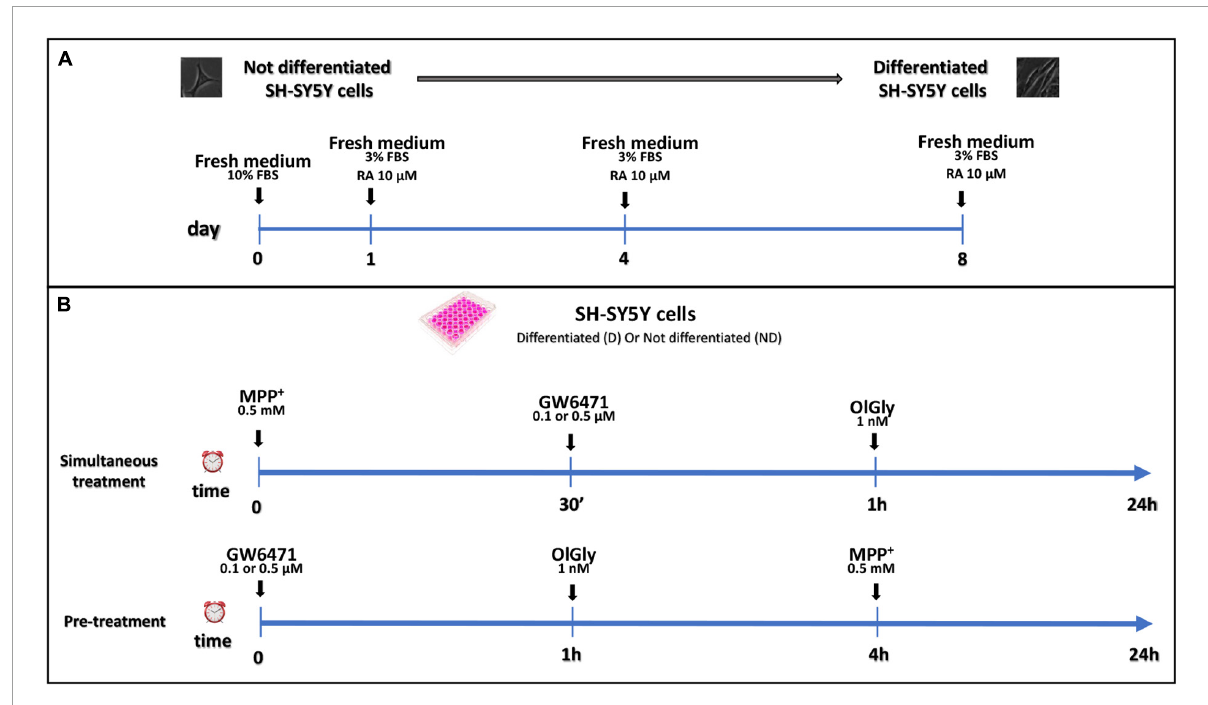
FIGURE1 Differentiation protocol (A) and study design (B) . (A) Proliferative SH-SY5Y cells were seeded and cultured in a medium supplemented with 10% FBS for 24 h for complete adhesion. After adhesion, RA differentiation was induced with the reduction of FBS to 3% and the addition of 10 µ M of RA. (B) Study design of simultaneous treatment (upper panel) and pre-treatment (bottom panel) experiments in not differentiated and differentiated SH-SY5Y cells. For simultaneous treatment experiments ( B , upper panel), SH-SY5Y cells were exposed to MPP + 0.5 mM to induce neurotoxicity. GW 6471 (0.5 or 0.1 µ M) and OlGly (1 nM) were added 30 min and 1 h, respectively, after MPP + treatment. For the pre-treatment experiments ( B , bottom panel), prior to MPP + treatment, SH-SY5Y was incubated with GW 6471 for 1 h and then with OlGly for 4